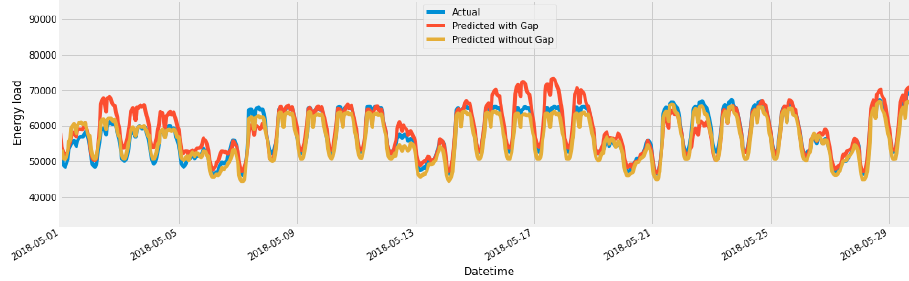
Figure 21. Comparison of hybrid model with and without imputation.